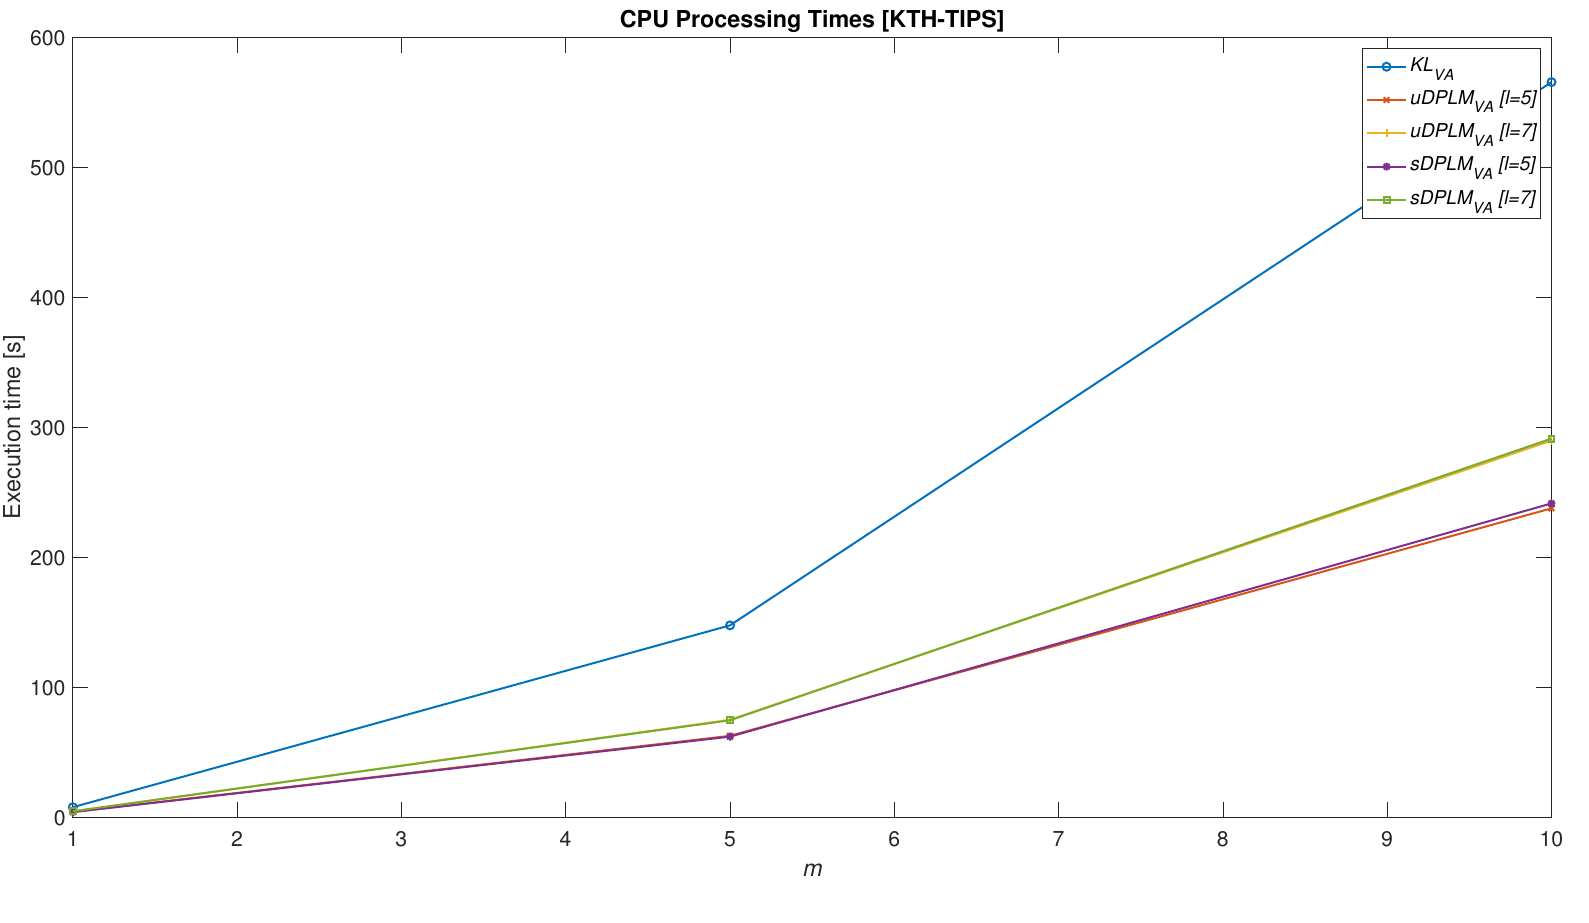
Figure 7. CPU processing times for the KTH-TIPS database, DPLM VA vs. KL VA